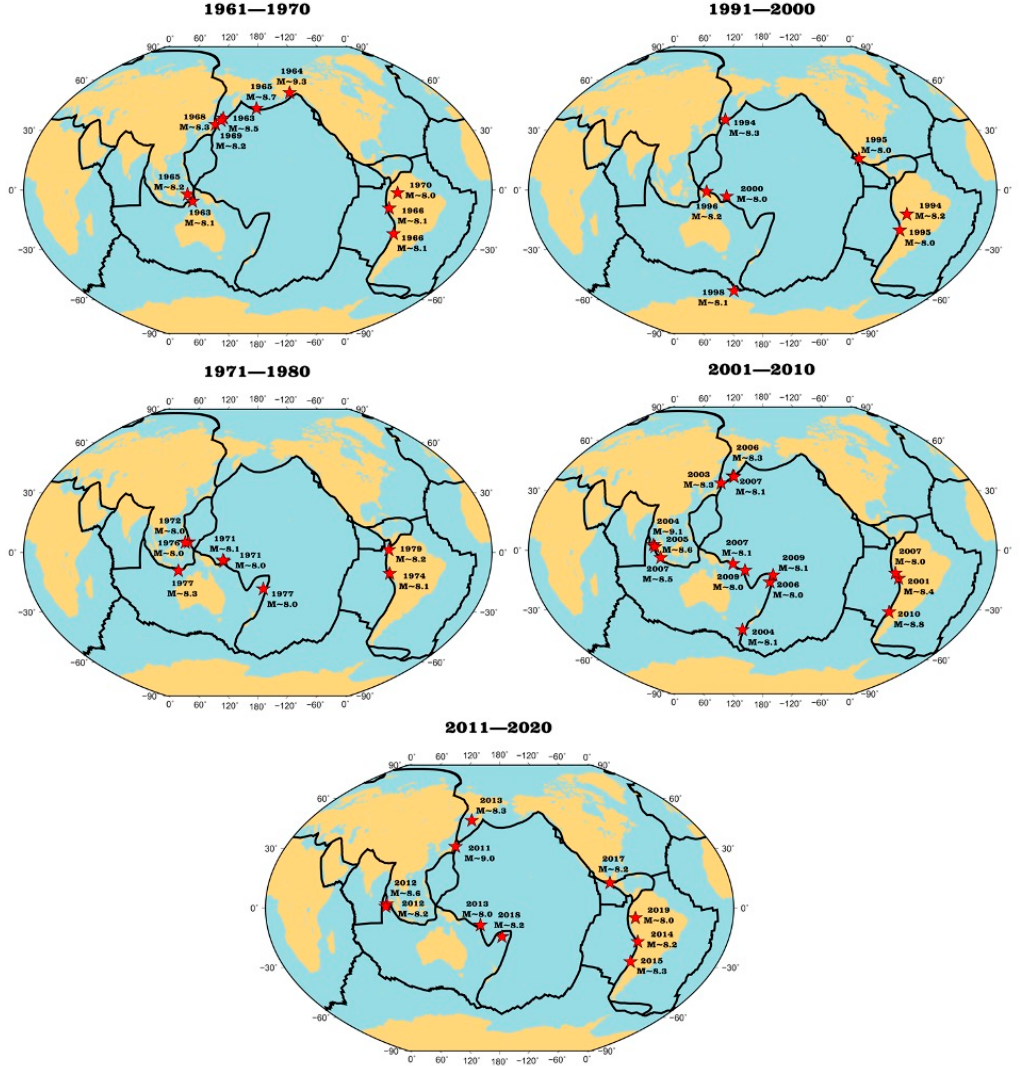
Figure 3. Global distribution of epicenters of the great earthquakes in 1951–2020. Plate boundaries according to NUVEL-1 model are shown as black lines; red stars indicate epicenters of earthquakes having magnitudes greater or equal to 8.0.